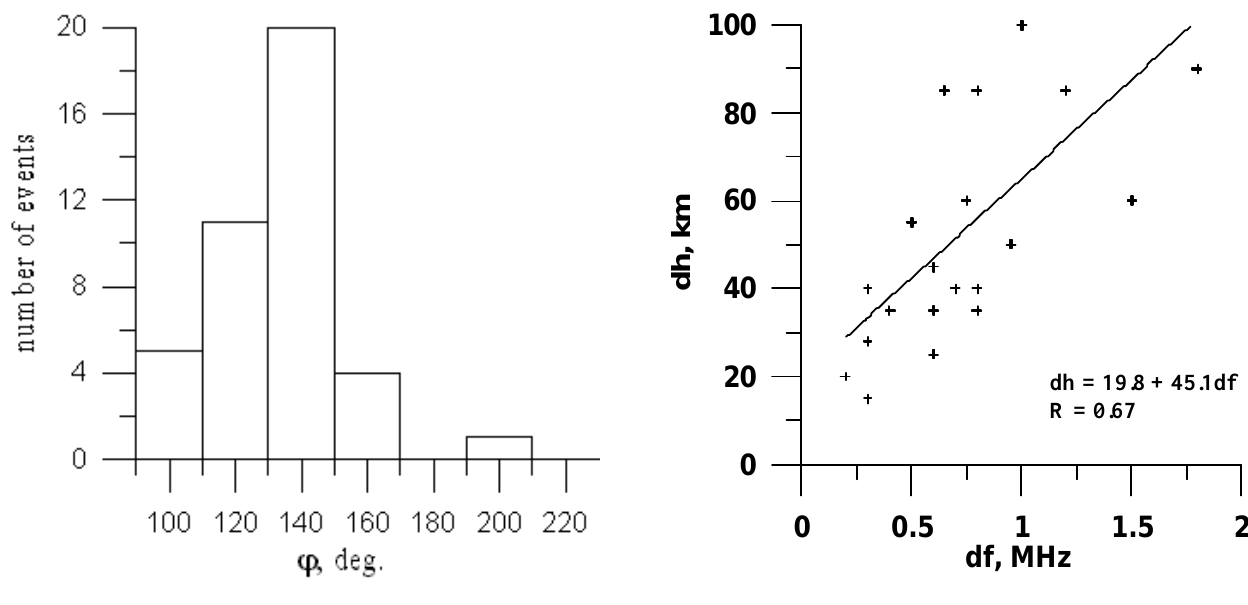
Fig. 5. Scatterplot of the peak-to-peak amplitudes of hm F variations ( dh ) versus those of f cr variations ( df